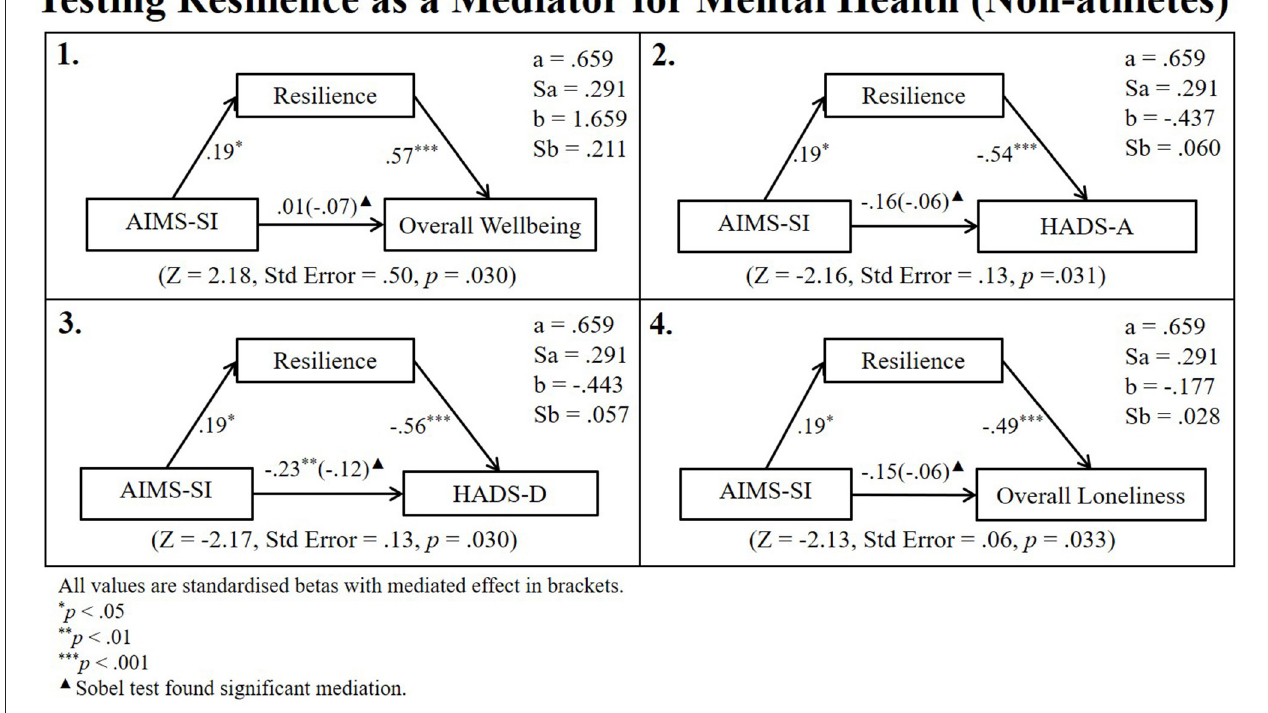
FIGURE 5 | Regression path diagram testing resilience as a mediator for non-athlete